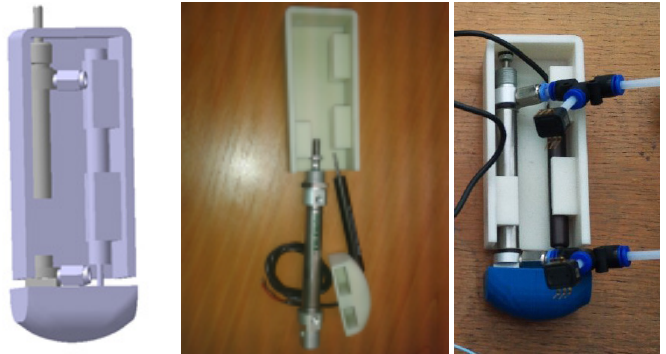
Figure 8. Haptic pneumatic probe (from the left to the right: CAD model, kit and assembled